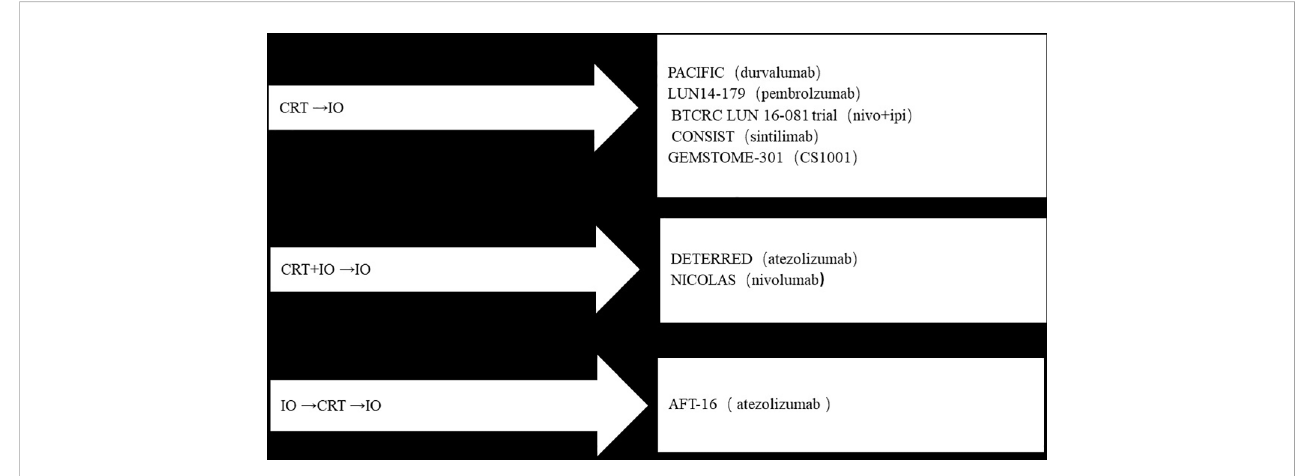
FIGURE 1 Summary of all the immunotherapy studies of locally advanced